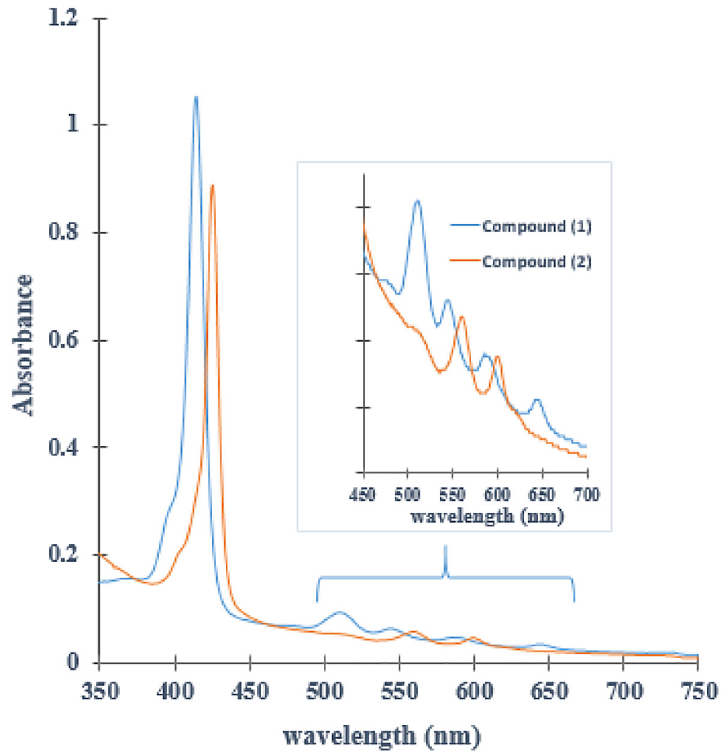
Figure 2. UV-Vis spectrum ( 1 ) and ( 2 ). The bands α and β represent the Q band in the porphyrin Sn (IV) complex ( 2